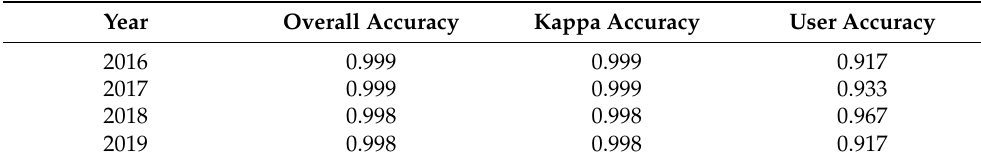
Table 2. Overall accuracy, Kappa coefficients and User accuracy of image